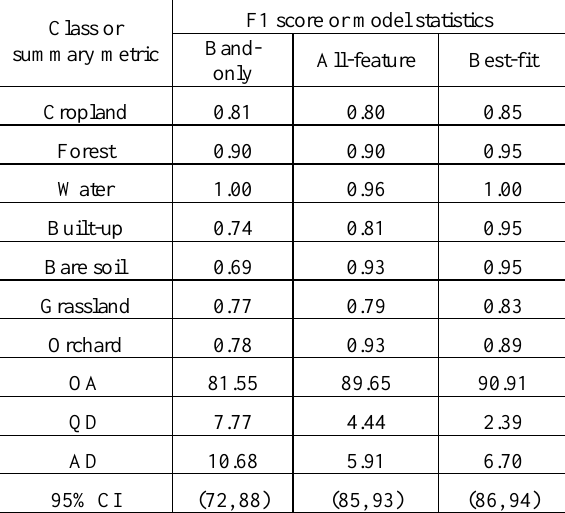
Table 5. Accuracy results for band-only, all-feature, and best-fit (MDA) model.